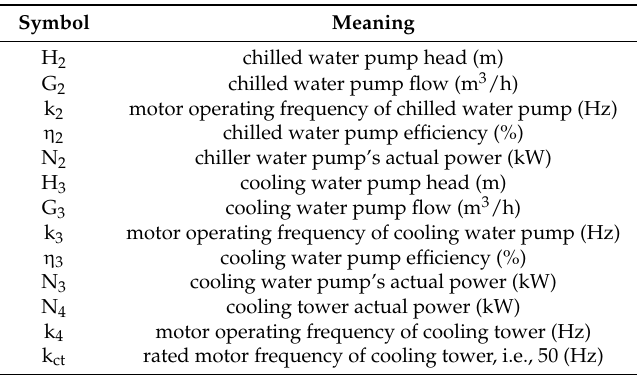
Table 5. Symbols and their